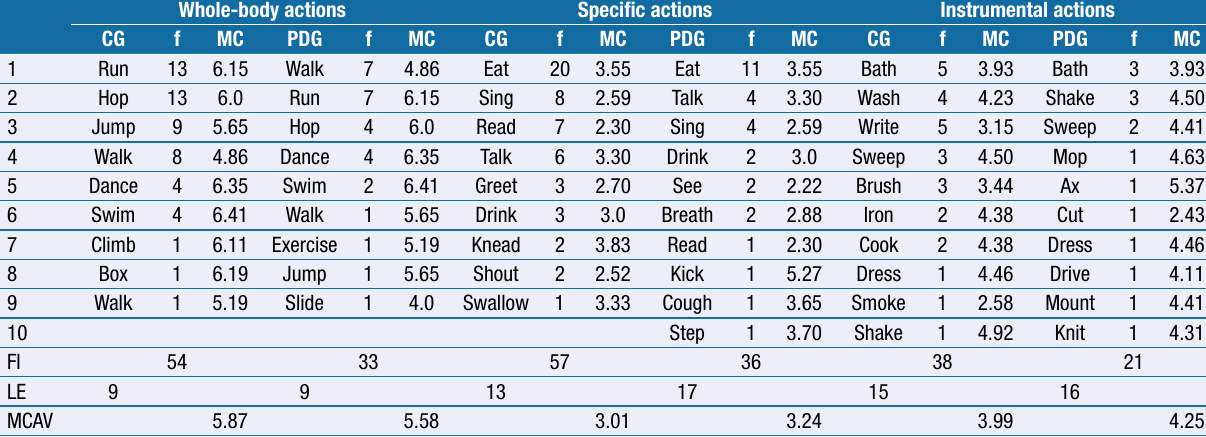
Table 2. The most frequent verbs produced (initial production order); the rest of the verbs (up to teen) are presented by the sequence of appearance in the overall